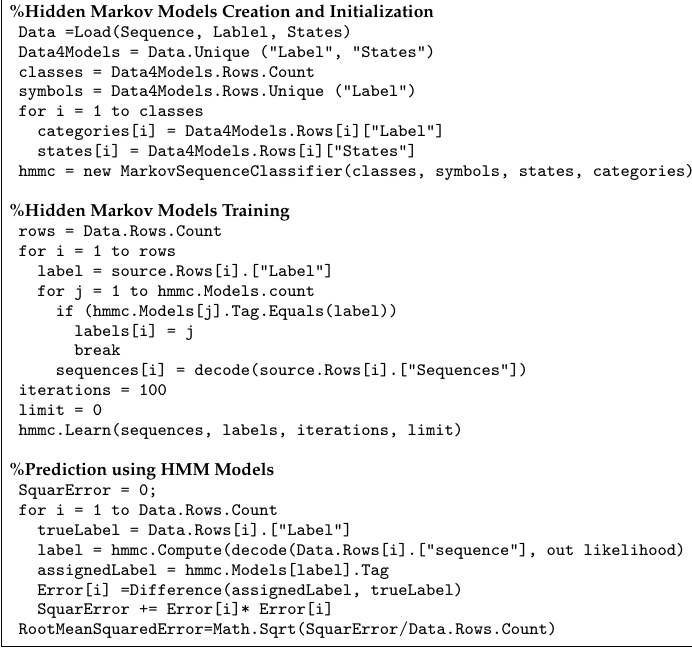
Figure 5. Pseudo-code for HMM creation, training and testing based on Accord.NET framework.